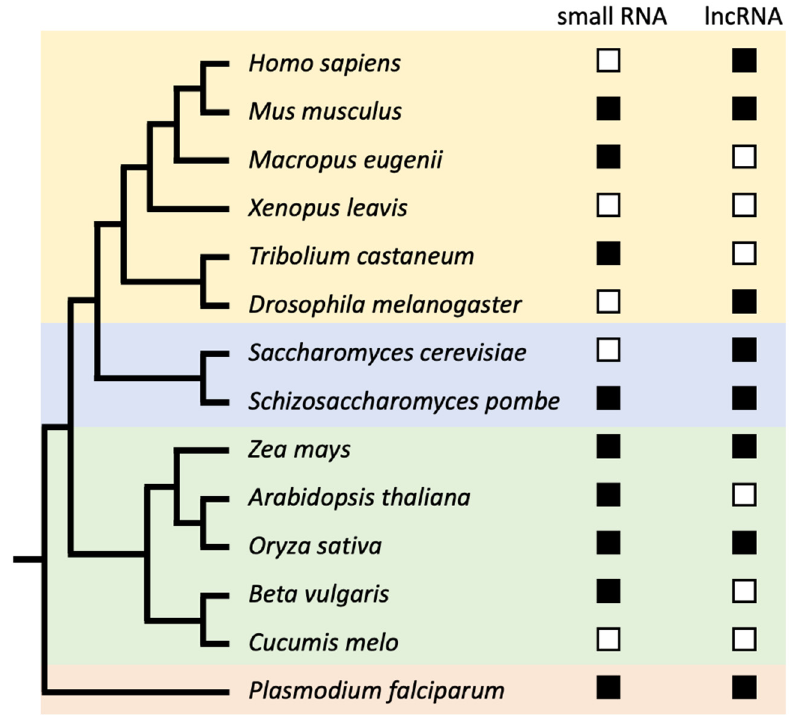
Figure 1. Cladogram showing which types of transcripts have been found in which species. The presence of centromeric small RNAs ( < 200 nt) and centromeric lncRNA ( > 200 nt) is shown behind each species described in Table 1. The colors yellow, blue, green, and red represent the Animalia, Fungi, Plantae, and Chromista kingdoms, respectively.